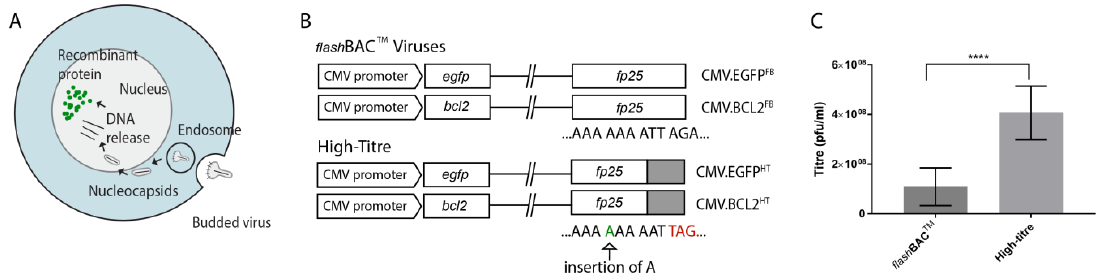
Figure 1. ( A ) schematic representation of BacMam mediated gene delivery into mammalian cells (transduction). Budded viruses are taken up by endocytosis and released into the cytoplasm. The nucleocapsids are directed to the nucleus where the DNA is released for transcription under the control of a mammalian promoter and the resultant mRNA is then translated into the recombinant protein; ( B ) schematic representation of flash BAC™ (FB) and high-titre (HT) egfp and bcl2 BacMam vectors. The fp25 mutation results from the insertion of an adenine causing a frameshift and an early stop codon (red letters); ( C ) comparison of the infectious titres from 10 FB and HT BacMam viruses as determined by plaque assay. Results were plotted using Graphpad Prism (error bars represent ± SD) and analysed using a Student’s t -test ( p < 0.05).